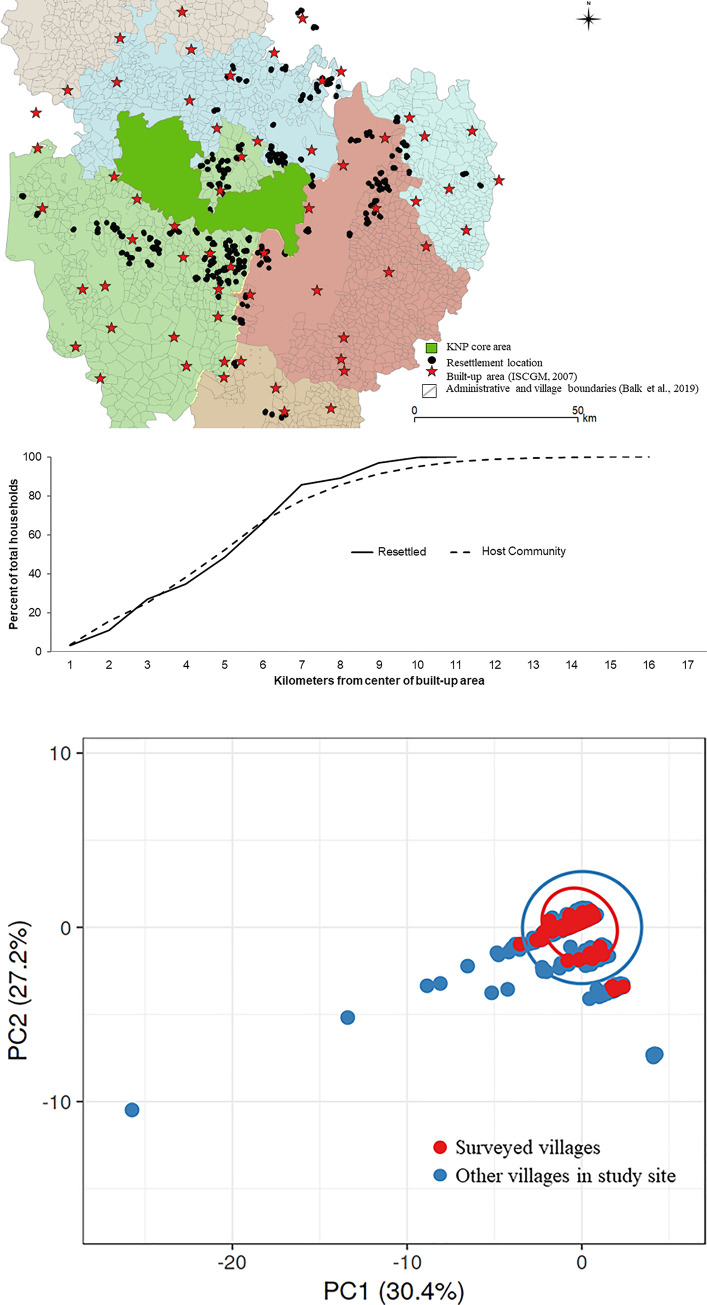
Survey is a subset of landscape-wide characteristics.(a) Map shows locations of built up area (red stars) [50], village boundaries color coded into administrative units (tehsils) [64] and locations of resettled households (black dots) used to calculate Euclidean distances between rural populations and urban centers. (b) Resettled households proportionally mirror densities of host community human densities across urban-rural transition in the KNP landscape (chart below map). In our study, resettled households were within 11 kilometers of a built up area (for other remoteness measurements see S3 File). (c) PCA results showing that our surveyed villages (red) are clearly a subset of the larger set of villages (blue) in the landscape–when compared across variables of village area (including forest area and unirrigated area) and remoteness measurements (presence of highways and distance to nearest town) using data from the Government of India census [43]. X and Y axis show principal component 1 and principal component 2 that explain 30.4% and 27.2% of the total variance, respectively. Prediction ellipses are such that with probability 0.95, a new observation from the same group will fall inside the ellipse. N = 1076 data points (for more PCA details and density plots of variables used see S4 File).